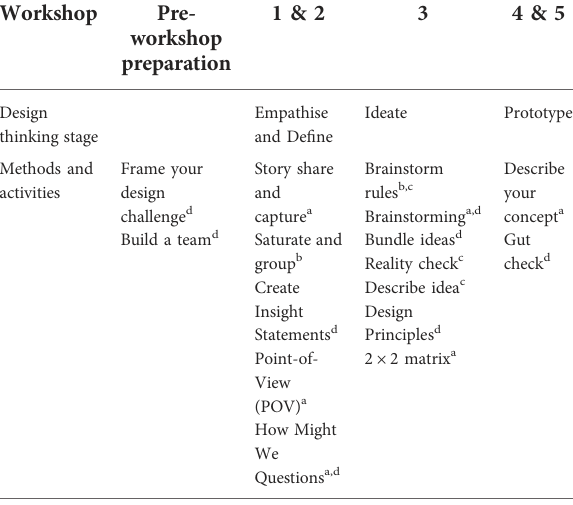
TABLE 1 List of toolkit activities undertaken in co-design